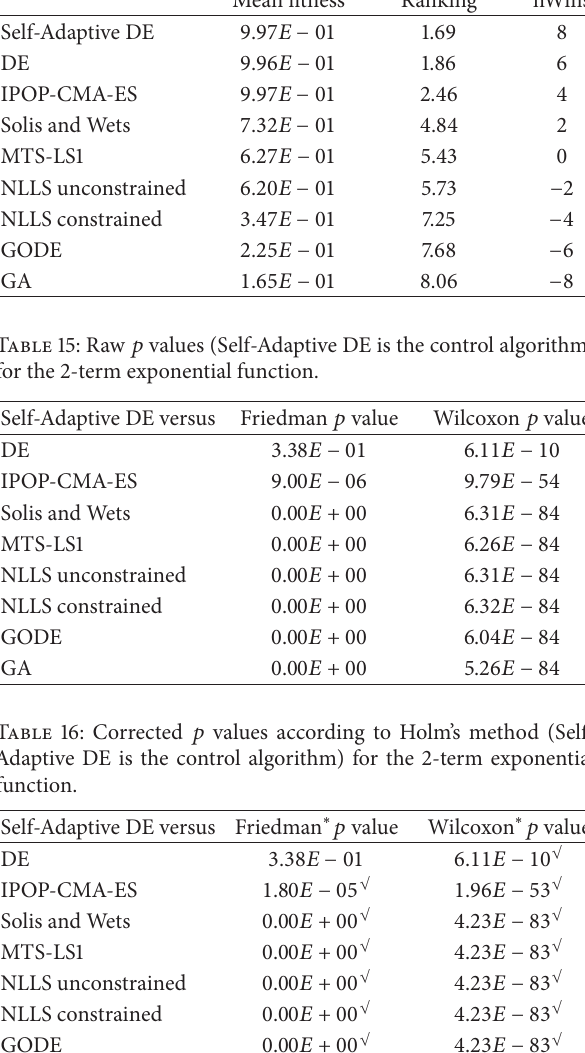
√ means that there are statistical differences with significance level 𝛼 = 0.05 .